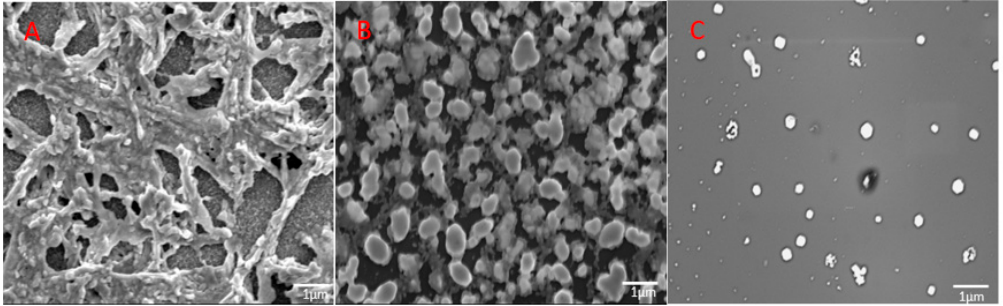
Figure 6. Scanning electron microscopy (SEM) results for sample ( A ) (MAPbI 3 ), ( B ) (Mixed MAPbI 3 , CsPbI 3 ), and ( C ) (MAPbI 3 with CsI &CsPbI 3 surface-passivation).